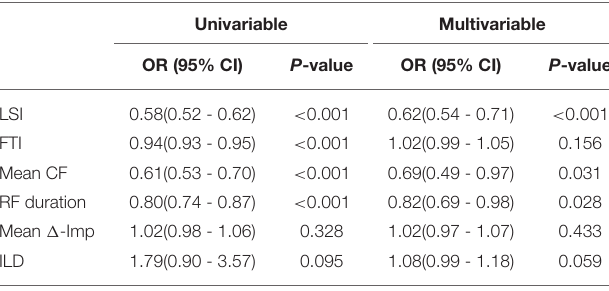
TABLE 5 | The univariable and multivariable logistic regression analysis for predicting acute conduction gap